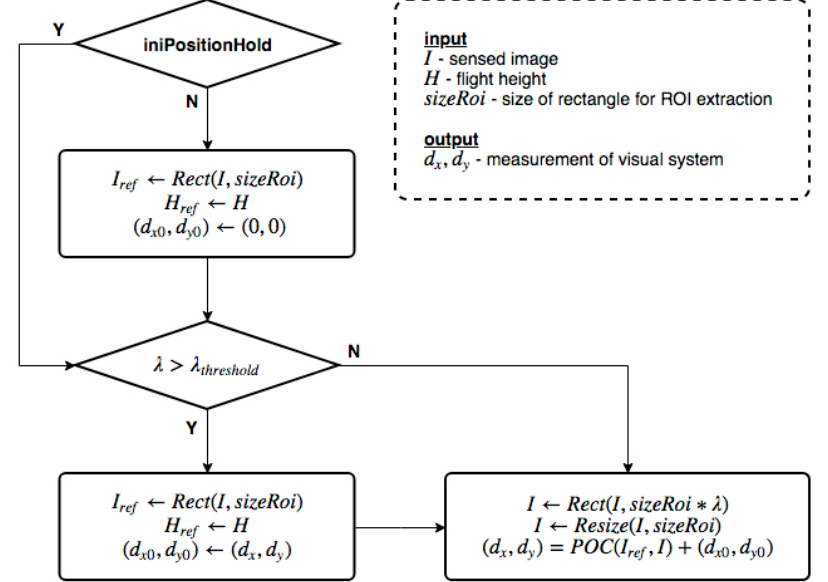
Figure 6. Flowchart of the multi-scale phase correlation. The reference ROI is autonomously updated when λ reaches a threshold value. When crossing different epoch of the reference ROI, the position measurement is carried out with the prior estimate as an initial condition.